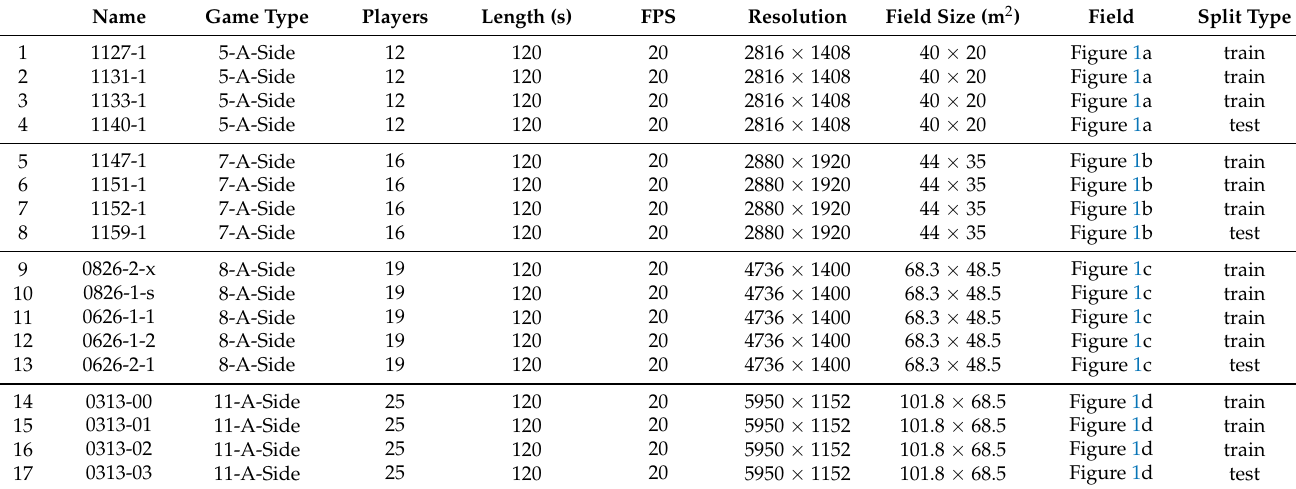
Table 2. NPSPT Video